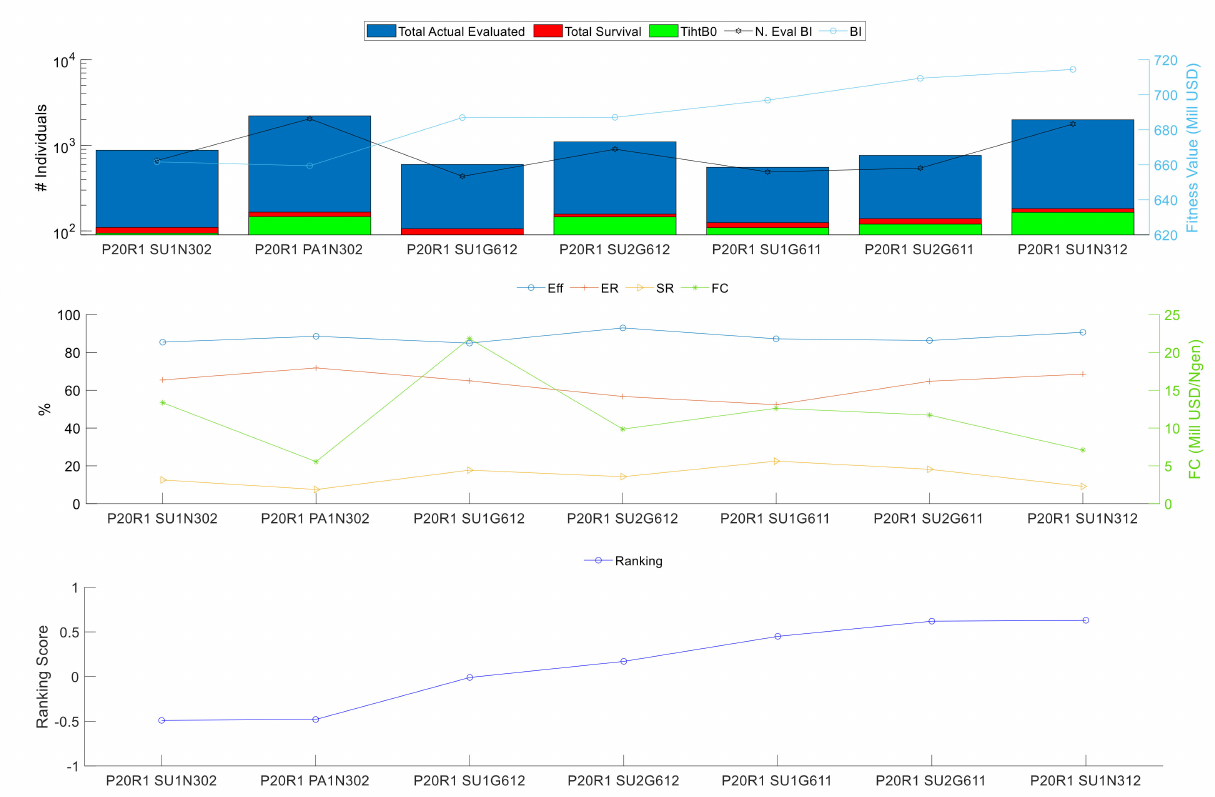
Figure 24. Summary of the performance indicators for POP20 R1. ( a ) shows variables of KPI 3,4 and 5 in bar chart, KPI 1 and variable of KPI 7 in line chart, ( b ) shows KPI 3,4,5 and 6 in line chart, ( c ) shows the ranking score based on Table